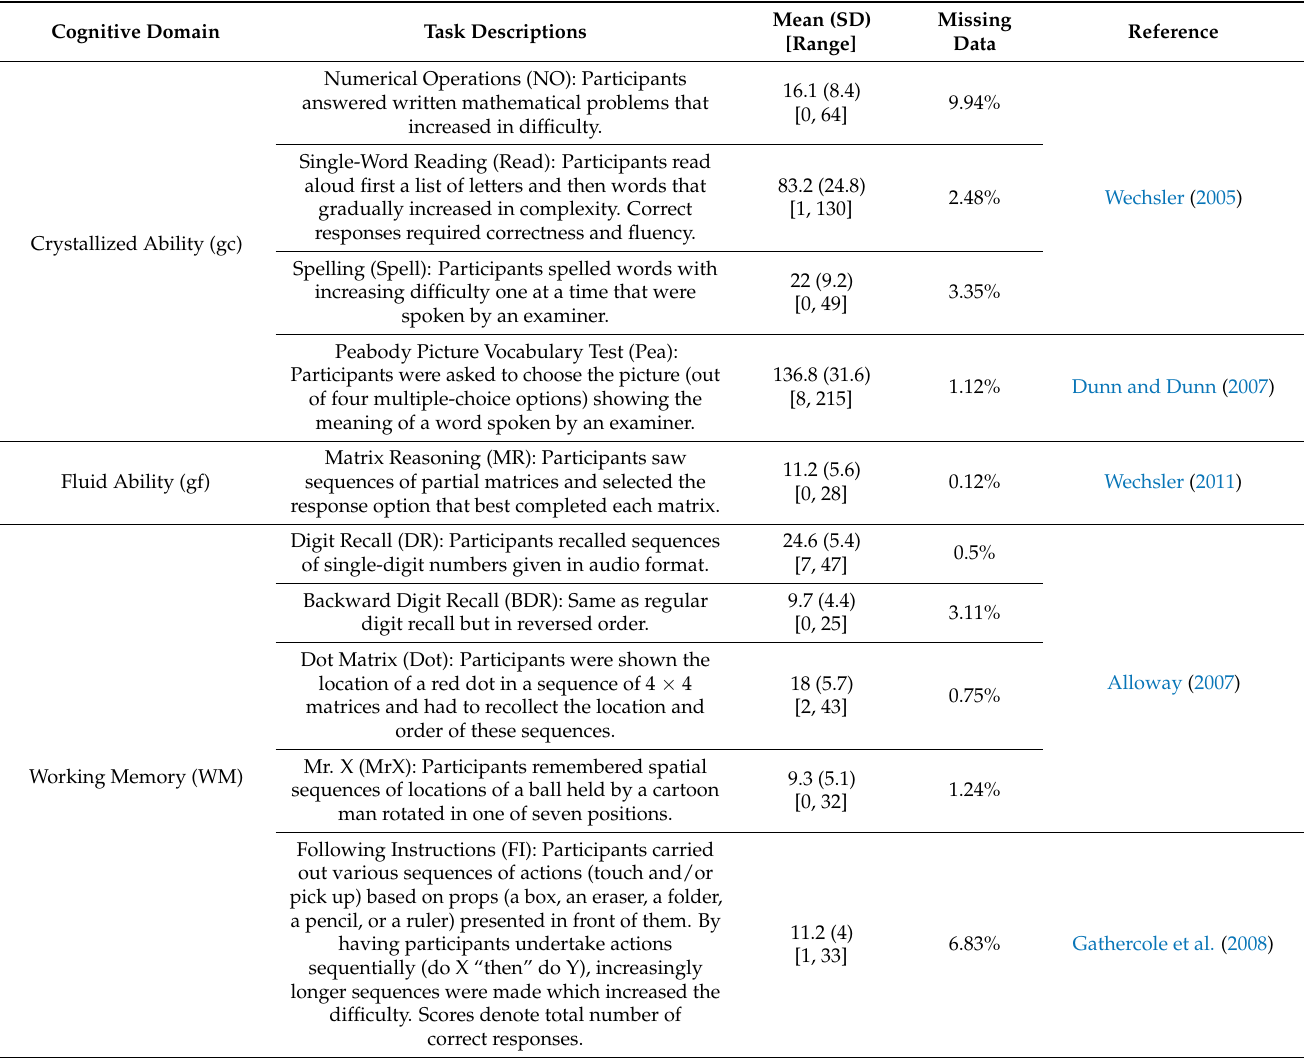
Table 1. List, descriptions, and summary statistics (mean, standard deviation, range, and percentage of missing data) of cognitive assessments used in this study from the CALM sample. Note, task descriptions (except following instructions) are taken directly or paraphrased from Simpson-Kent et al.